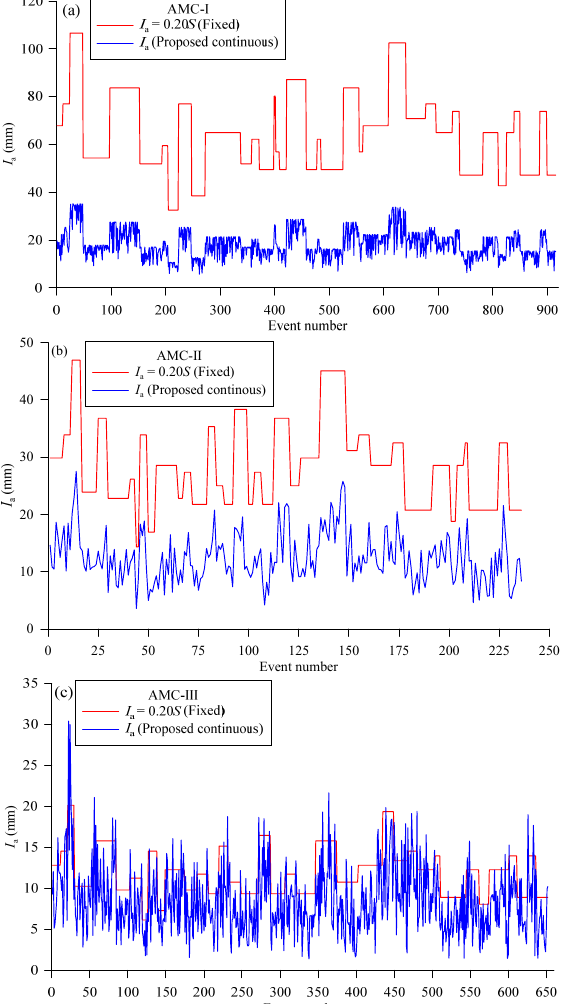
Figure 2. Variation of fixed and variable initial abstraction ( I a ) for rainfall events in ( a ) dry condition; ( b ) normal condition; and ( c ) wet condition.